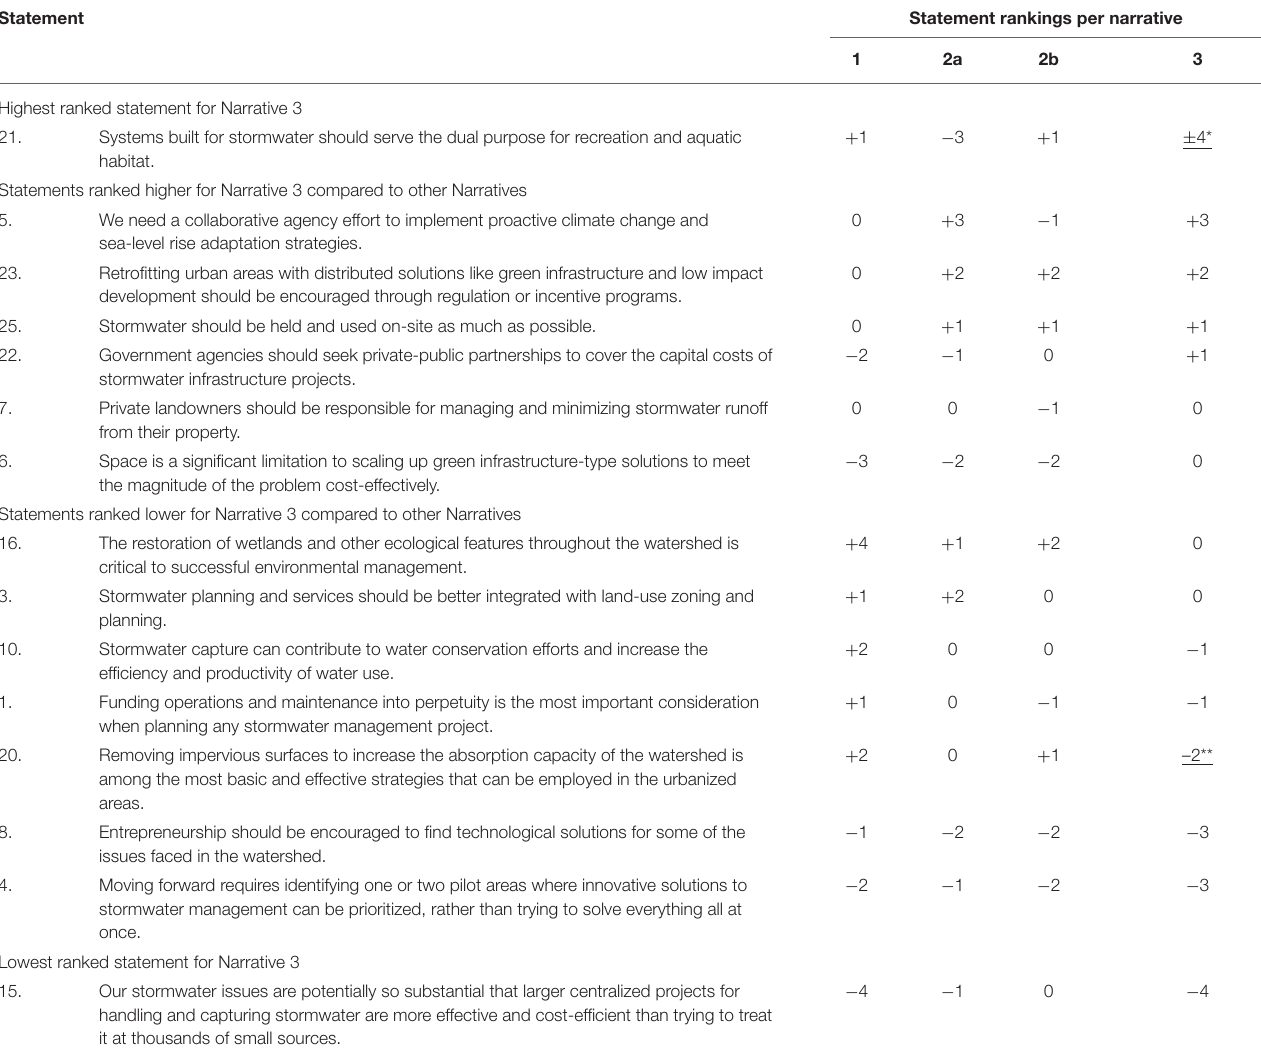
TABLE 7 | Summary of notable statements for Narrative 3 (PC